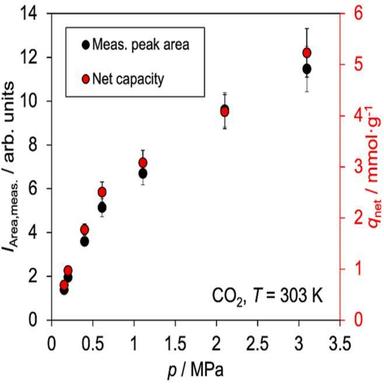
Raman spectroscopic analysis on CO2 adsorption to silica gel: (black) measured peak area profile of adsorbed CO2 before corrections for refractive index, and (red) net adsorption capacity of silica gel converted from Raman peak area analysis, including corrections for refractive index.